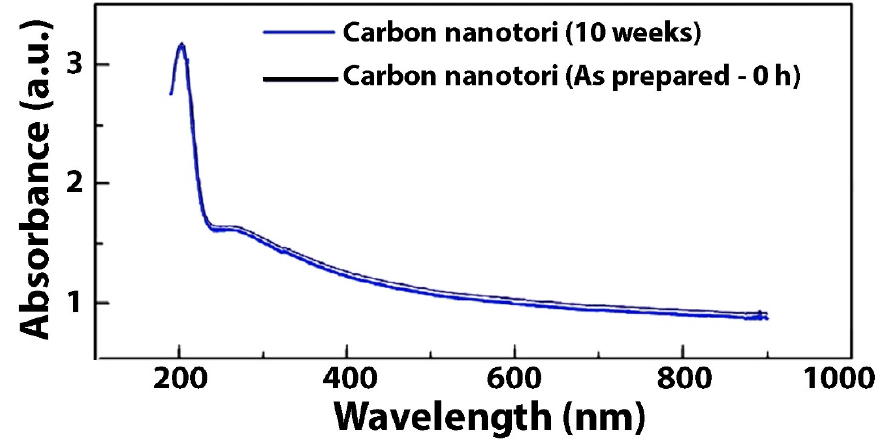
Figure 3. Raman spectrum for carbon nanotori structures. Table 1. Material